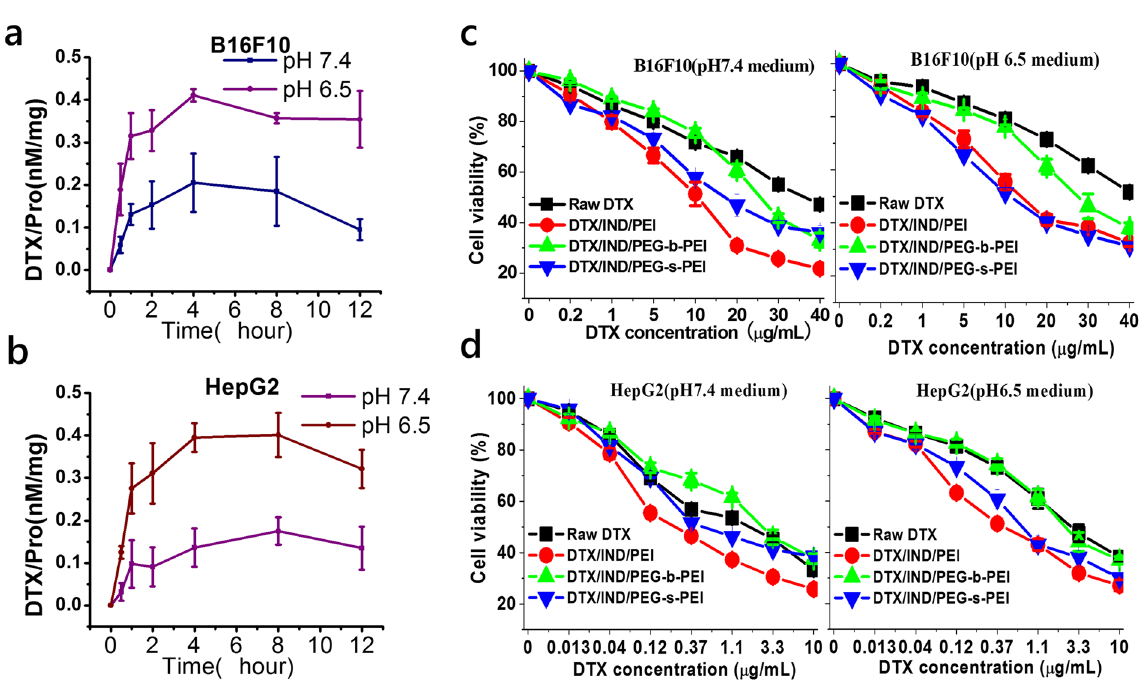
Figure 4. Cellular retention of internalized drug in tumor cells after endocytosis. ( a , b ) Time dependent DTX concentration changes after DTX/IND/PEG-s-PEI endocyozied by B16F10 ( a ) and HepG2 ( b ) in normal and acidy mediums. ( c , d ) In vitro antitumor activity of DTX nanomedicines formulated from DTX/IND/PEG-s-PEI assemblies against B16F10 ( c ) and HepG2 ( d ) in normal and acidy mediums. Data are mean ± S.E. (standard error, n =